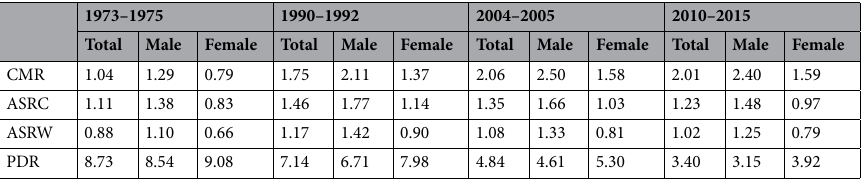
Table 1. Younger lung cancer mortality in Hebei Province from 1973 to 2015. ASRC age-standardized rate using China standard population (2000), ASRW age-standardized rate using World standard population,